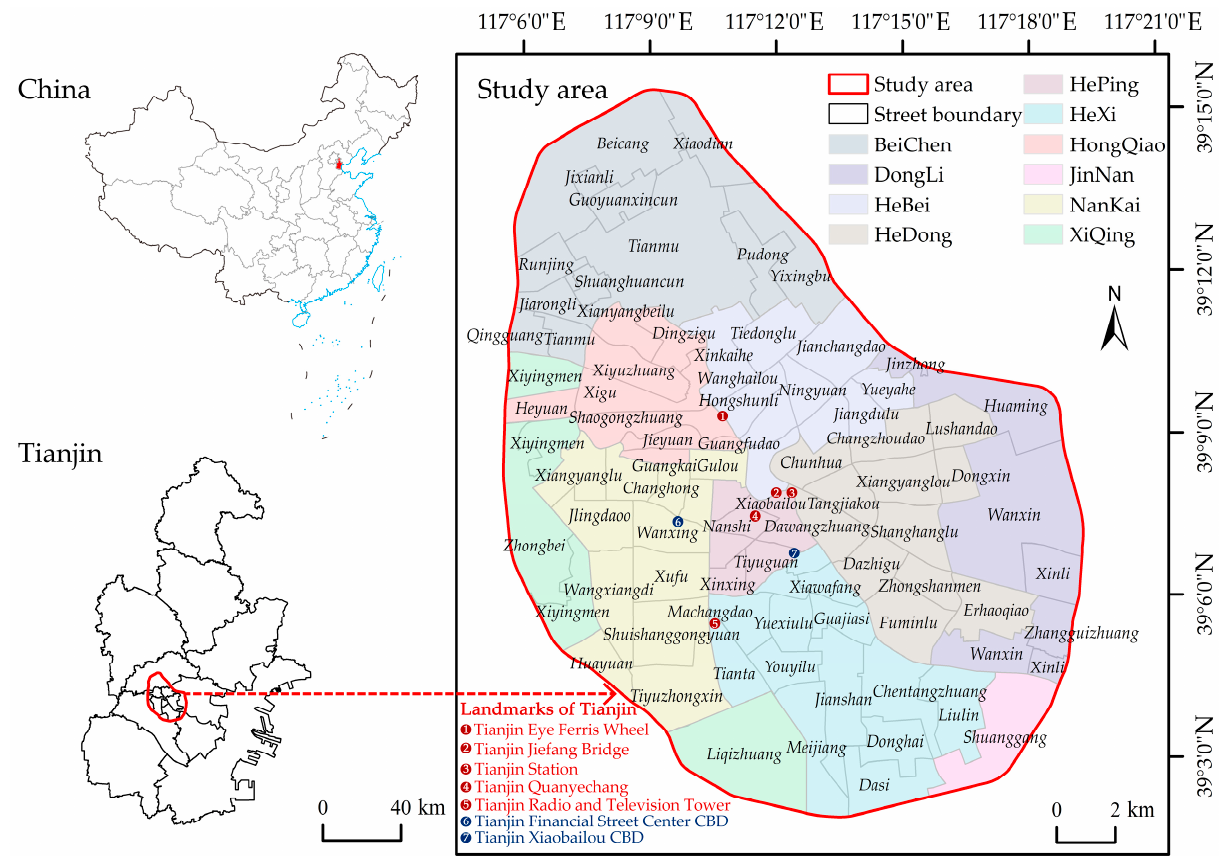
Figure 1. The geographical location and administrative division of the central urban area of Tianjin.